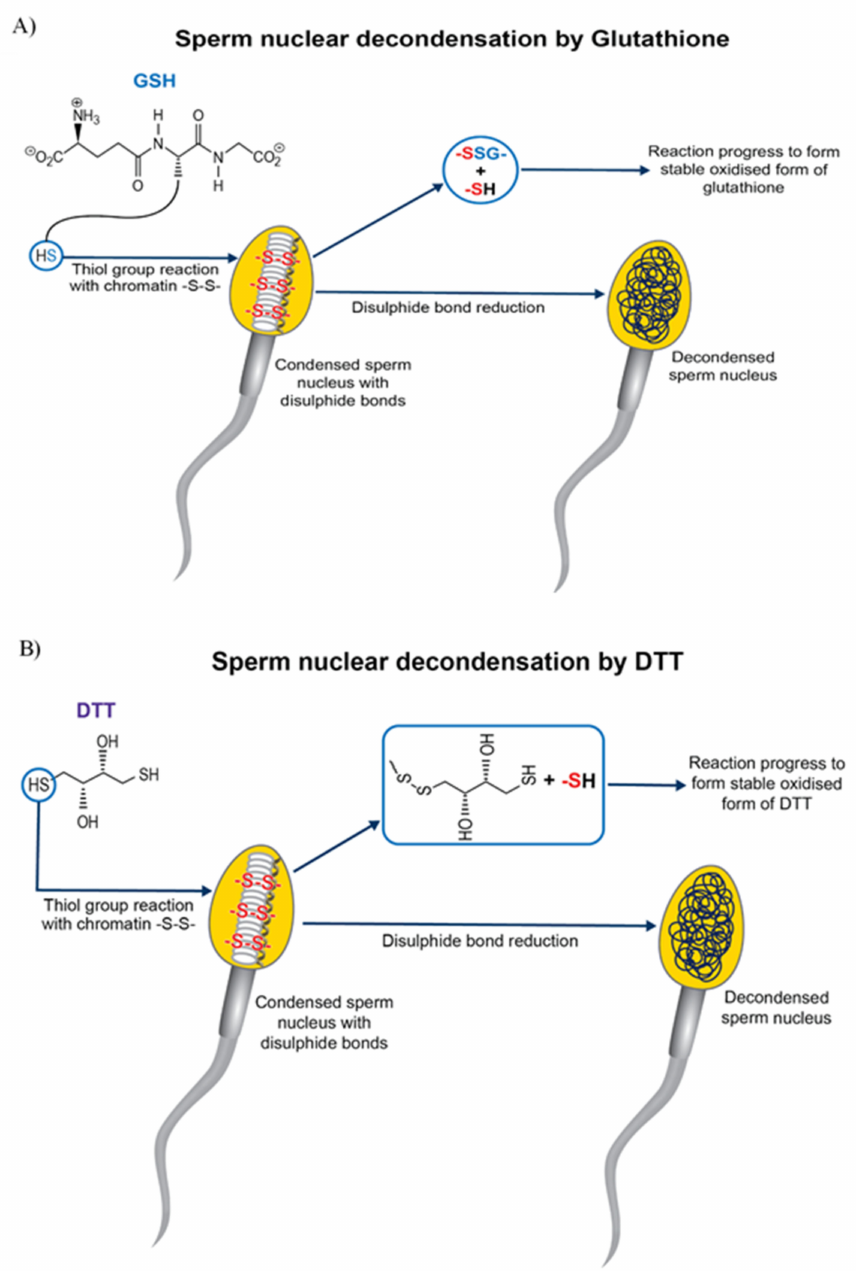
Figure 1. Sperm nuclear decondensation by disulphide bond reduction by thiol reagents. ( A ) Glutathione (GSH) reduces the disulphide bond in a condensed sperm nucleus, forming a mixed disulphide compound (-GSS-), along with a sulfhydryl compound (-SH). The reaction further pro- gresses in the presence of thiol transferases enzymes, forming more stable oxidised GSH, using another molecule of GSH. Reduction of the disulphide bond results in decondensation of the sperm nucleus. ( B ) Dithiothreitol (DTT), a dithiol compound, reduces disulphide bonds in the condensed sperm nucleus, resulting in its decondensation. The reaction results in the formation of a sulfhydryl compound (-SH) and mixed disulphide compound (involving sulphur from DTT and sulphur from sperm nucleus), resulting in immediate reorganisation of its disulphide bond to form more stable oxidised DTT. This thiol-disulphide exchange is maximum when media pH equals pKa of DTT (9.0). Pre-treatment of bovine sperm with detergents e.g., lysolecithin (LL) or Triton X- 100 (TX) [104] along with glutathione before ICSI, induces plasma membrane disruption and promotes nuclear decondensation [104]. The former improved the rate of